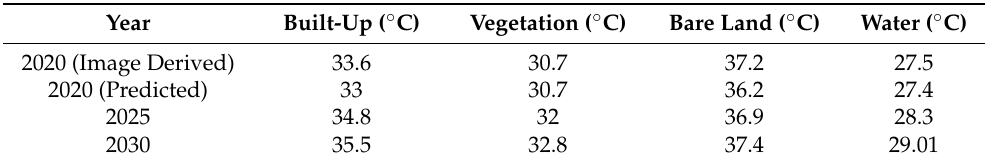
Table 6. Validation of change in LST (by comparing predicted results for 2020 with the image derived results for the same year) and prediction for the year 2021, 2025 and